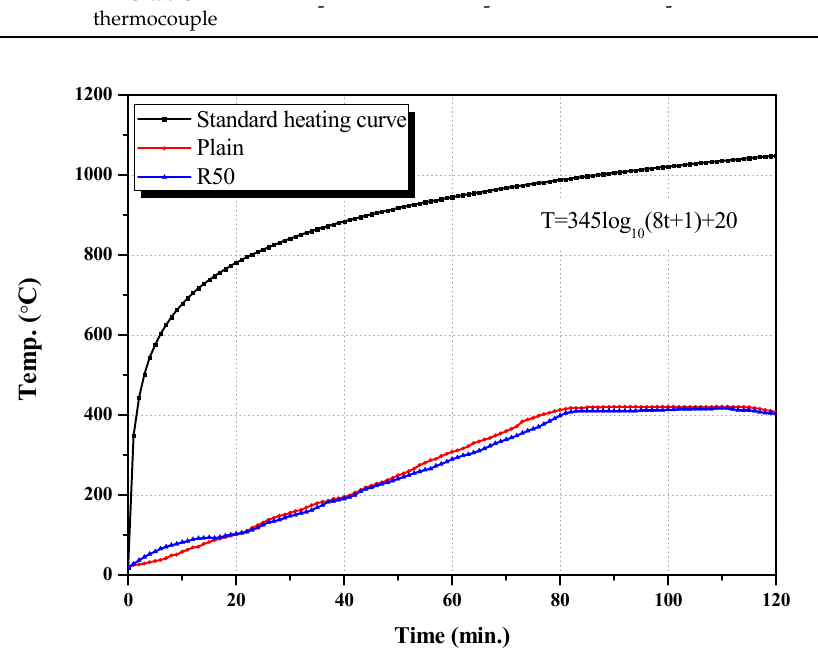
Figure 12. Time vs. temperature curves in fire-resistance tests.